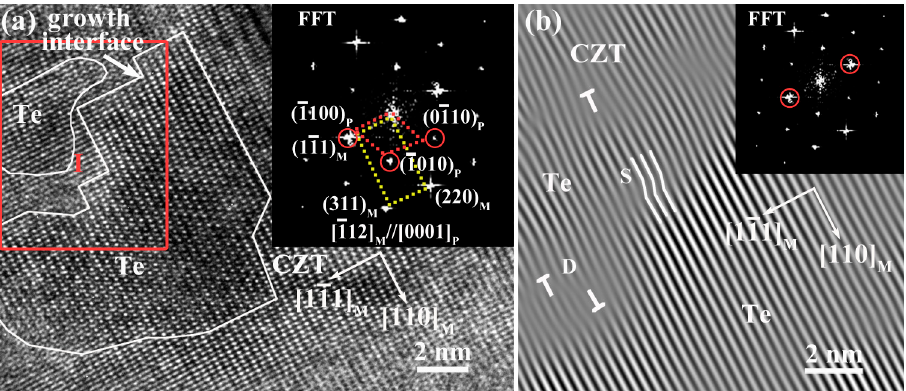
Figure 3. HRTEM image of the specimen near the tail of the ingot with fast cooling rate (60 °C/h) after growth. ( a ) The HRTEM image. ( b ) The inverse FFT image was reconstructed by using the 1100 spatial frequencies shown in the inset of ( b ). The insets in ( a , b ) correspond to FFT patterns of region I in ( a